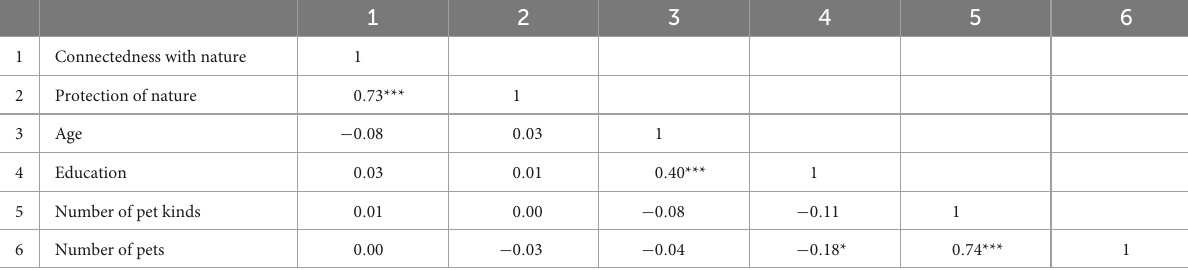
TABLE 3 Correlations between the two environmental identity (EID) scale factors, age, education, number of pet types, and number of pets (Spearman’s ρ